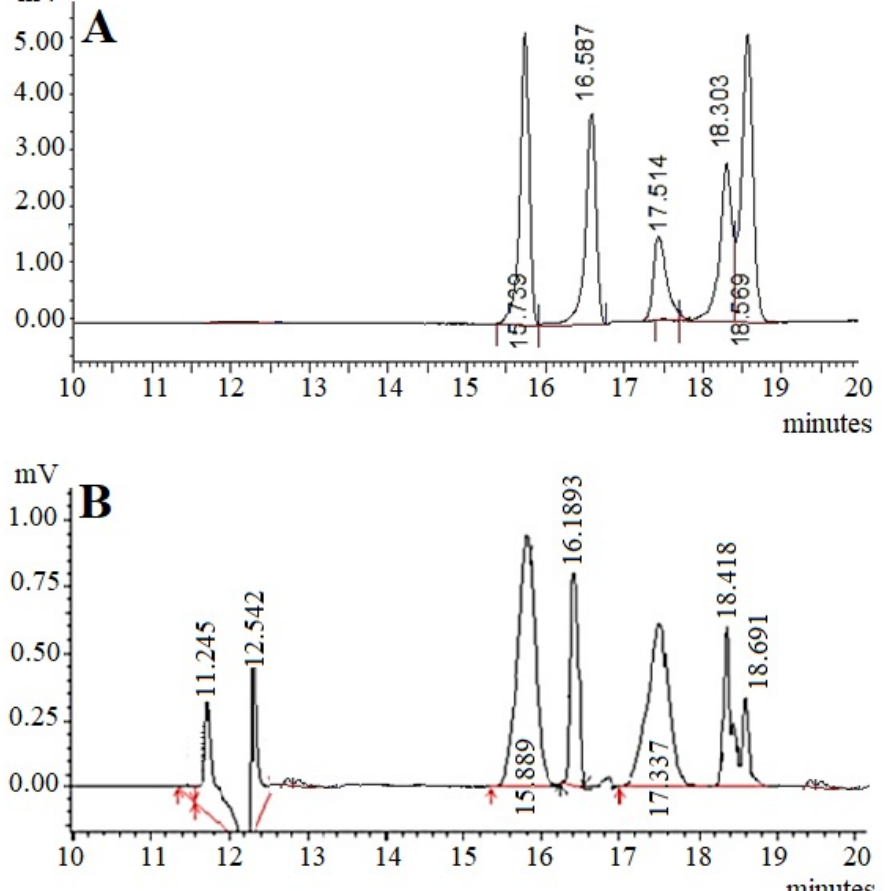
Figure 1. HPLC chromatograms of monosaccharide standard samples ( A ) and hydrolyzed RAP) ( B ). Glucose (RT 15.739 min), galactose (RT 16.587), mannose (RT 17.514), arabinose (RT 18.303), and fucose (RT 18.569). RAP: Rhododendron arboreum polysaccharides; RT: Retention time.